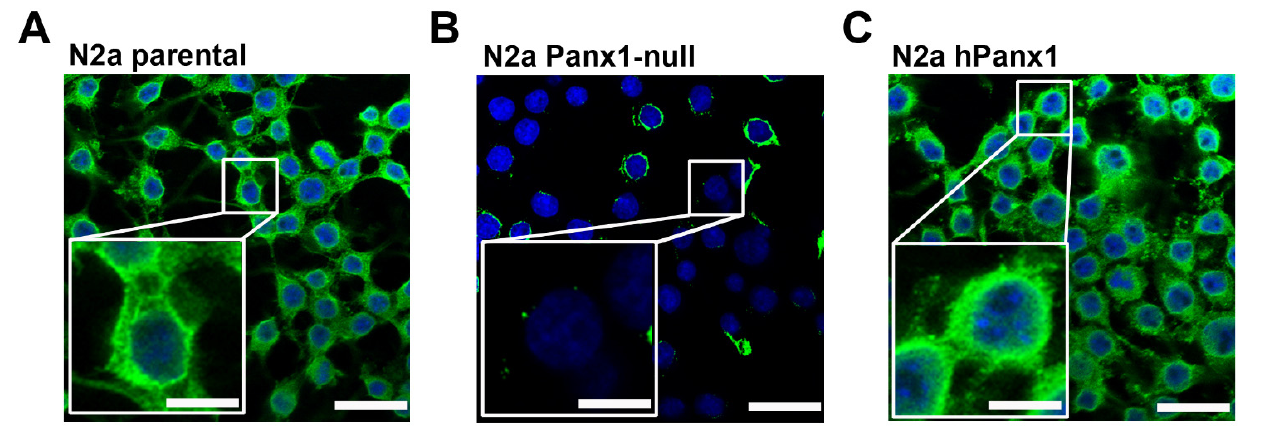
Figure 1. Expression of endogenous Panx1 is largely absent in CRISPR-deleted N2a cells. Representative confocal images obtained from ( A ) parental, ( B ) Panx1-deleted, and ( C ) Panx1-deleted N2a cells expressing human (h) Panx1 construct. Boxed white areas show the Panx1 staining at higher magnification. Scale bars: 50 µm lower magnification, 20 µm in boxed areas.